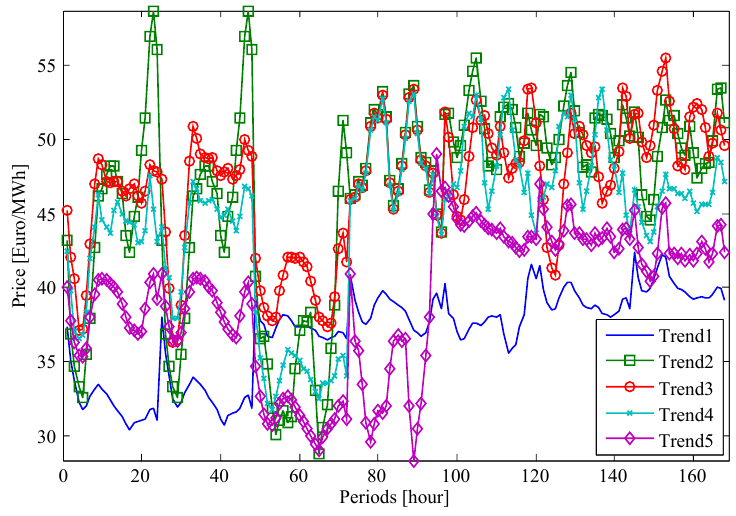
Figure 8. Input data of the forecasted trends.